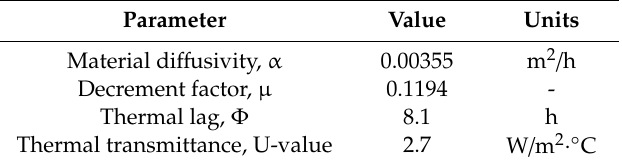
Table 3. Theoretical results of the steady-state and dynamic thermal parameters for the Earthbag